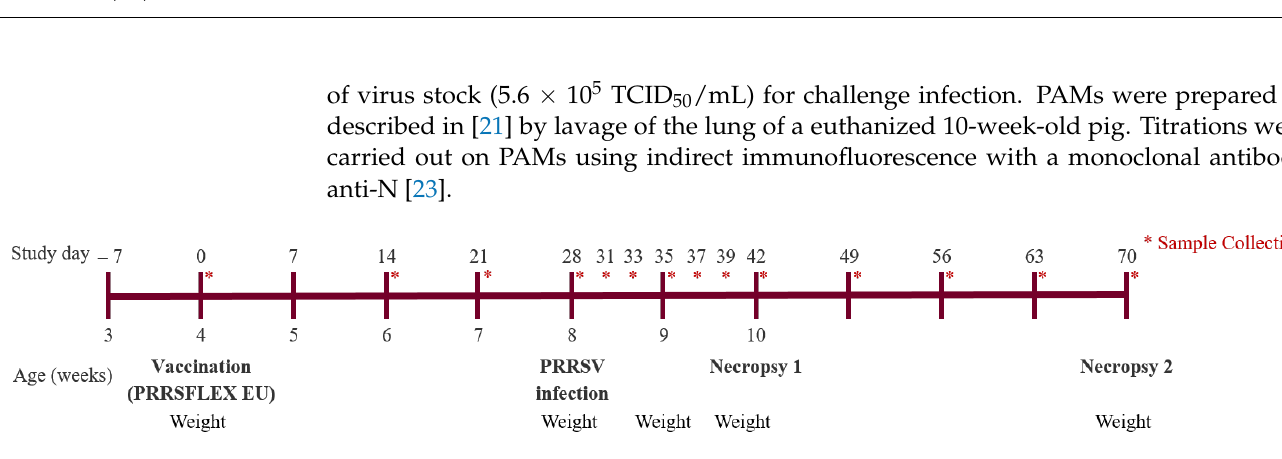
Figure 1. Timeline of the experiment. Study days on the top, age of the animals in weeks below.